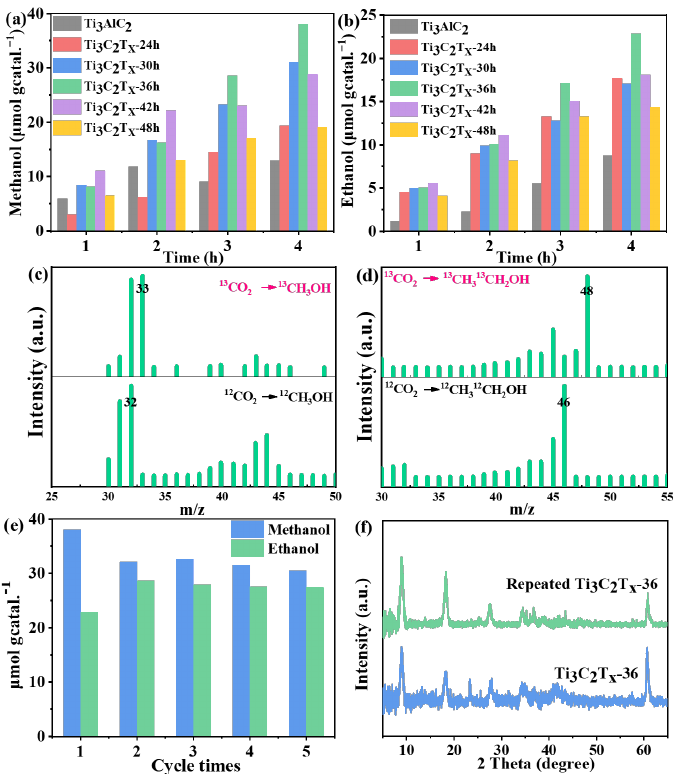
Figure 5. Yields of ( a ) methanol and ( b ) ethanol from photocatalytic CO 2 reduction under visible light. GC-MS spectra of ( c ) 13 CH 3 OH and ( d ) 13 C 2 H 5 OH using 13 CO 2 and 12 CO 2 as the source of CO 2 . ( e ) Cycling runs for CO 2 reduction over Ti 3 C 2 T x -36. ( f ) XRD patterns of fresh and repeated Ti 3 C 2 T x - 36.